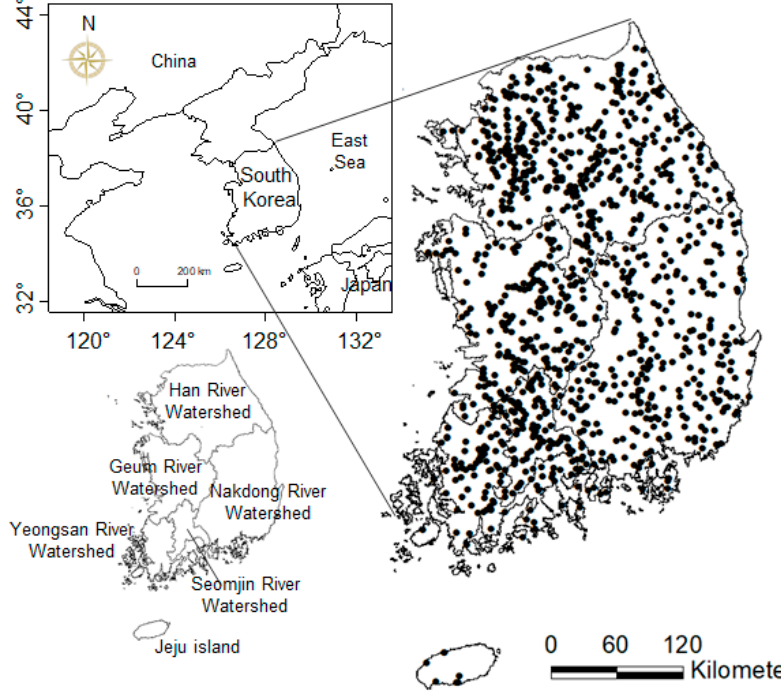
Figure 1. A map of sampling sites in South Korea.